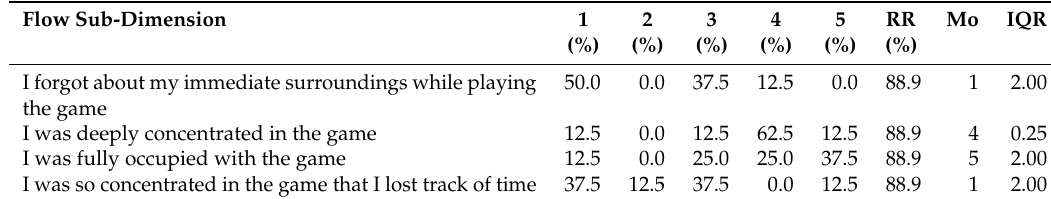
Table A3. MARISA Game feedback—Flow.